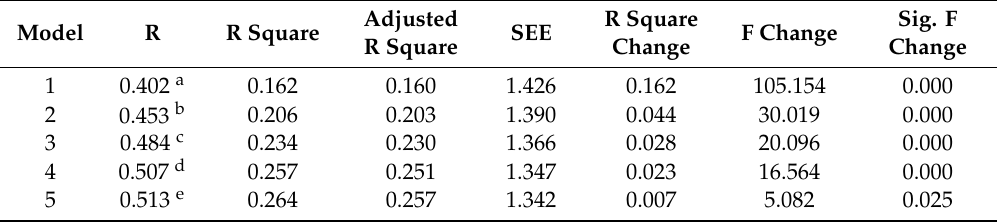
Table 2. Multiple regression analysis identifying the change in the variance of dietary diversity scores of women from small holder family farms in the Imbabura Province as variables are added in a stepwise fashion going from model 1 (1 variable) model 5 (5 significant predictor variables).